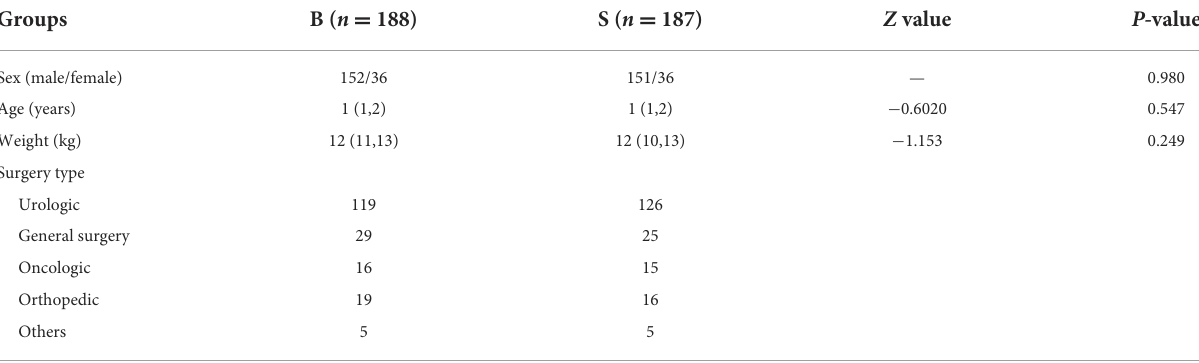
TABLE 2 Comparison of characteristics between bispectral index (B) and standard of care (S) groups.